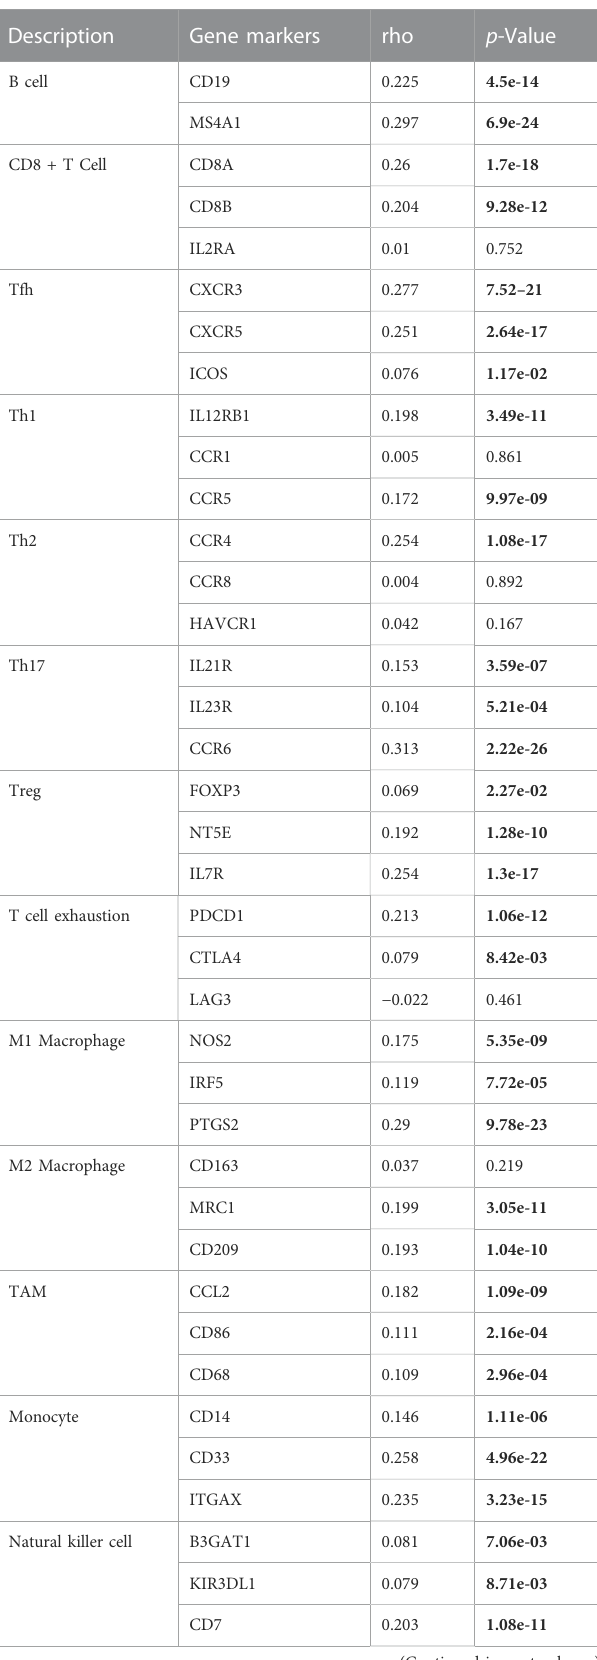
TABLE 2 Correlation analysis between KLF2 and immune cell marker gene in TIMER database.